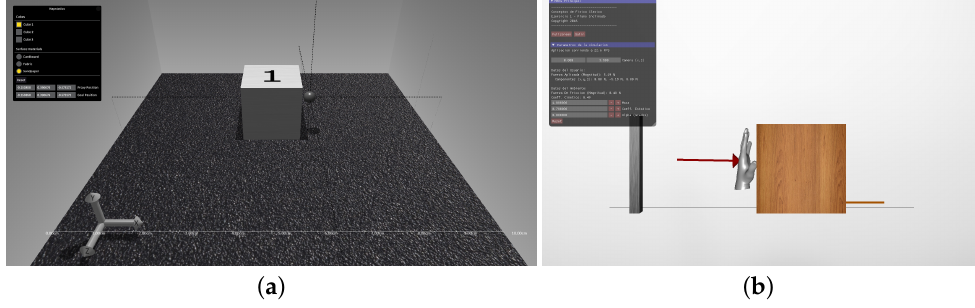
Figure 2. ( a ) visuo-haptic friction simulationcreated by Yuksel et al. [11] and ( b ) Friction scenario created by Neri et al.